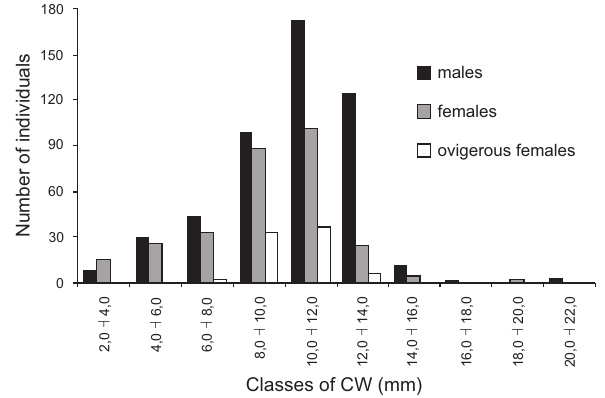
Figure 2. Absolute frequency of males, females and ovigerous fe- males in each CW class of U. rapax from Itaipu Lagoon.